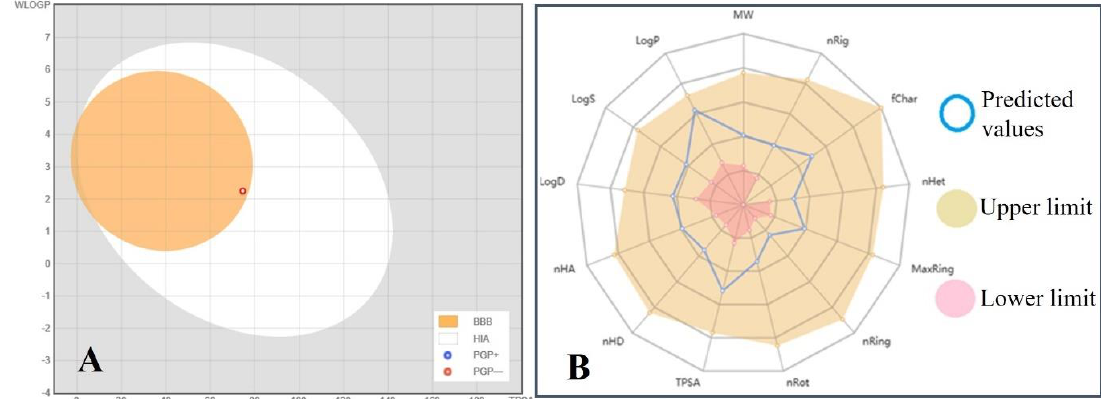
Figure 11. ( A ) A BOILED-Egg plot shows the blood-brain barrier (BBB) penetration and ABA molecules’ human intestinal absorption (HIA). Here PGP- shows the P-glycoprotein substrate negative nature of ABA. ( B ) Radar graph showing upper, lower, and predicted values of various physicochemical and molecular properties of ABA (Abbreviations: MW = Molecular weight, nRig = Number of rigid bonds, fChar = Formal charge, nHet = Number of heteroatoms, MaxRing = Number of atoms in the biggest ring, nRing = Number of rings, nRot = Number of rotatable bonds, TPSA = Toplogical polar surface area, nHD = Number of hydrogen bond donors, nHA = Number of hydrogen bond acceptors, LogP = Log of the octanol/water partition coefficient, LogS = Log of the aqueous solubility, LogD = Log at physiological pH 7.4.